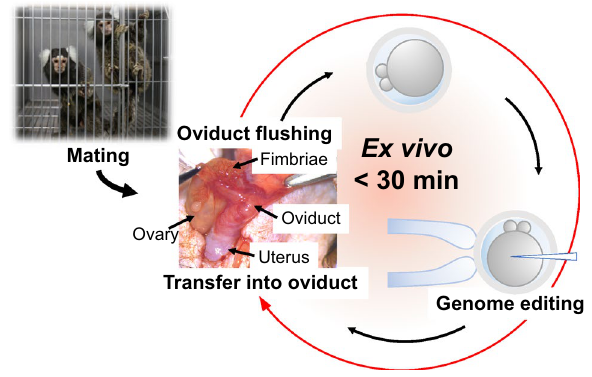
Figure 1. Autologous embryo transfer (AET). Pronuclear stage embryos are recovered from the oviducts of a naturally mating female by flushing. Immediately embryos are injected with Cas9 protein and guide RNAs. Injected embryos are transferred into the oviduct of the female providing the embryos. Injected embryos are exposed ex vivo for less than 30